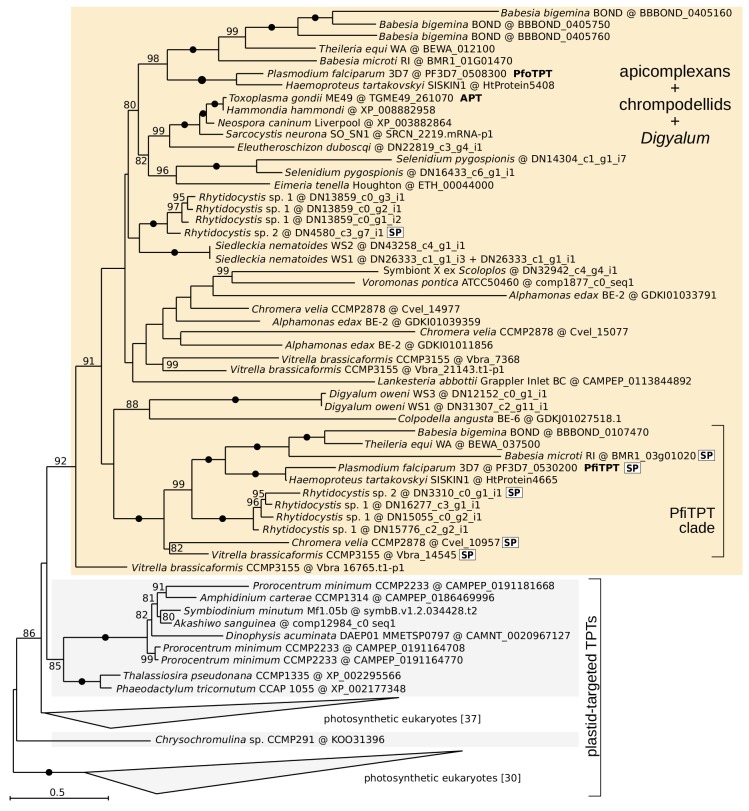
Maximum likelihood phylogeny of the triose phosphate translocator, TPT (LG+F+R7 model in IQ-TREE with 10000 UFBoot2 replicates;≥80 are shown; black dots indicate full support).Apicomplexans, chrompodellids and Digyalum are shown on orange background and other eukaryotes on gray background. Selected characterized proteins are highlighted in bold.